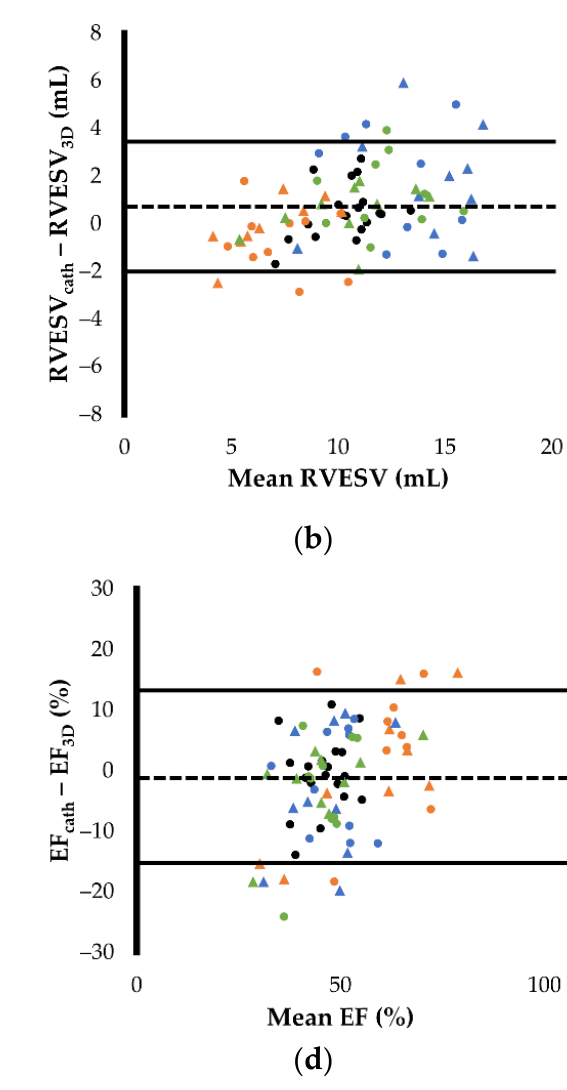
( d ) Figure 2. Correlations between the right ventricular morphology and function measured by right heart catheterization and real-time three-dimensional echocardiography: ( a ) end-diastolic right ventricular volume (RVEDV); ( b ) end-systolic right ventricular volume (RVESV); ( c ) stroke volume (SV); ( d ) ejection fraction (EF). Black round dots show the measurements of baseline. Orange round and triangular dots show the measurements of 5 and 10 µg/kg/min dobutamine infusions, respectively. Blue round and triangular dots show the measurements of 15 and 30 min after acute volume load, respectively. Green round and triangular dots show the measurements of 15 and 30 min after furosemide administration, respectively.